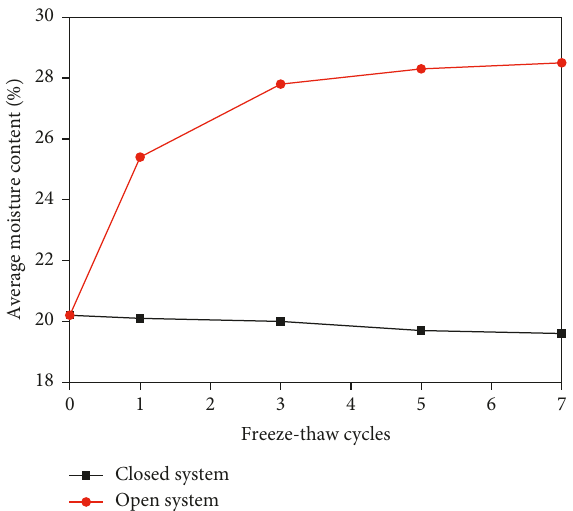
Figure 7: Variation of average moisture content with the freeze-thaw cycles.